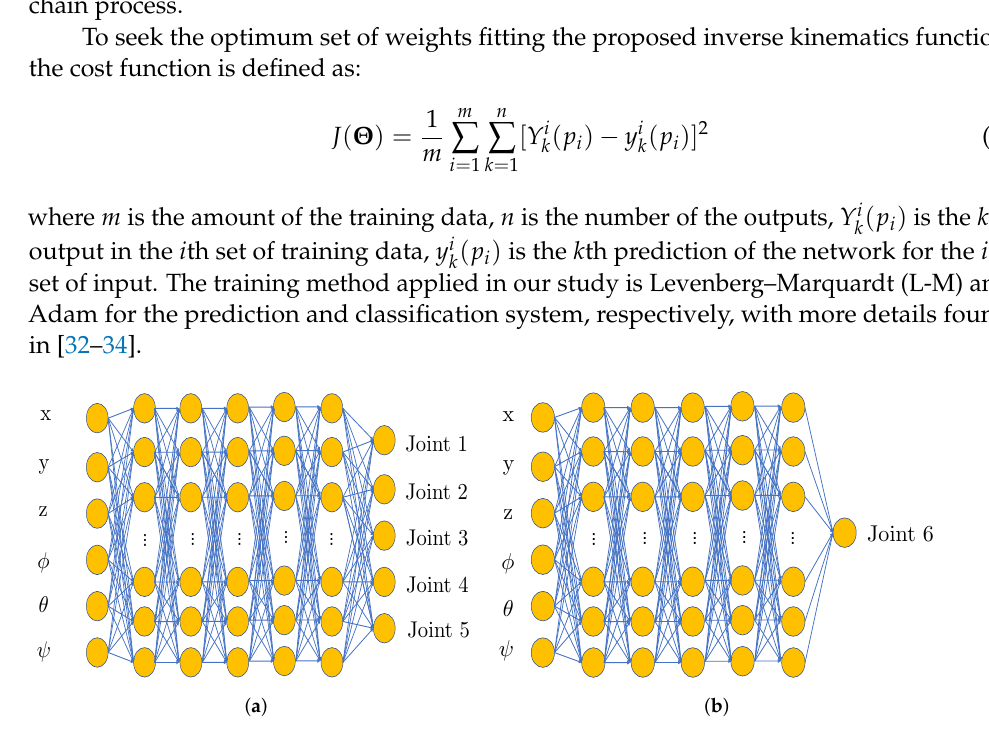
Figure 2. NN architecture for IKP. ( a ) NN for the first five joints; ( b ) NN for the last Fig. 2 NN architecture for IKP Fig. 2 NN architecture for IKP